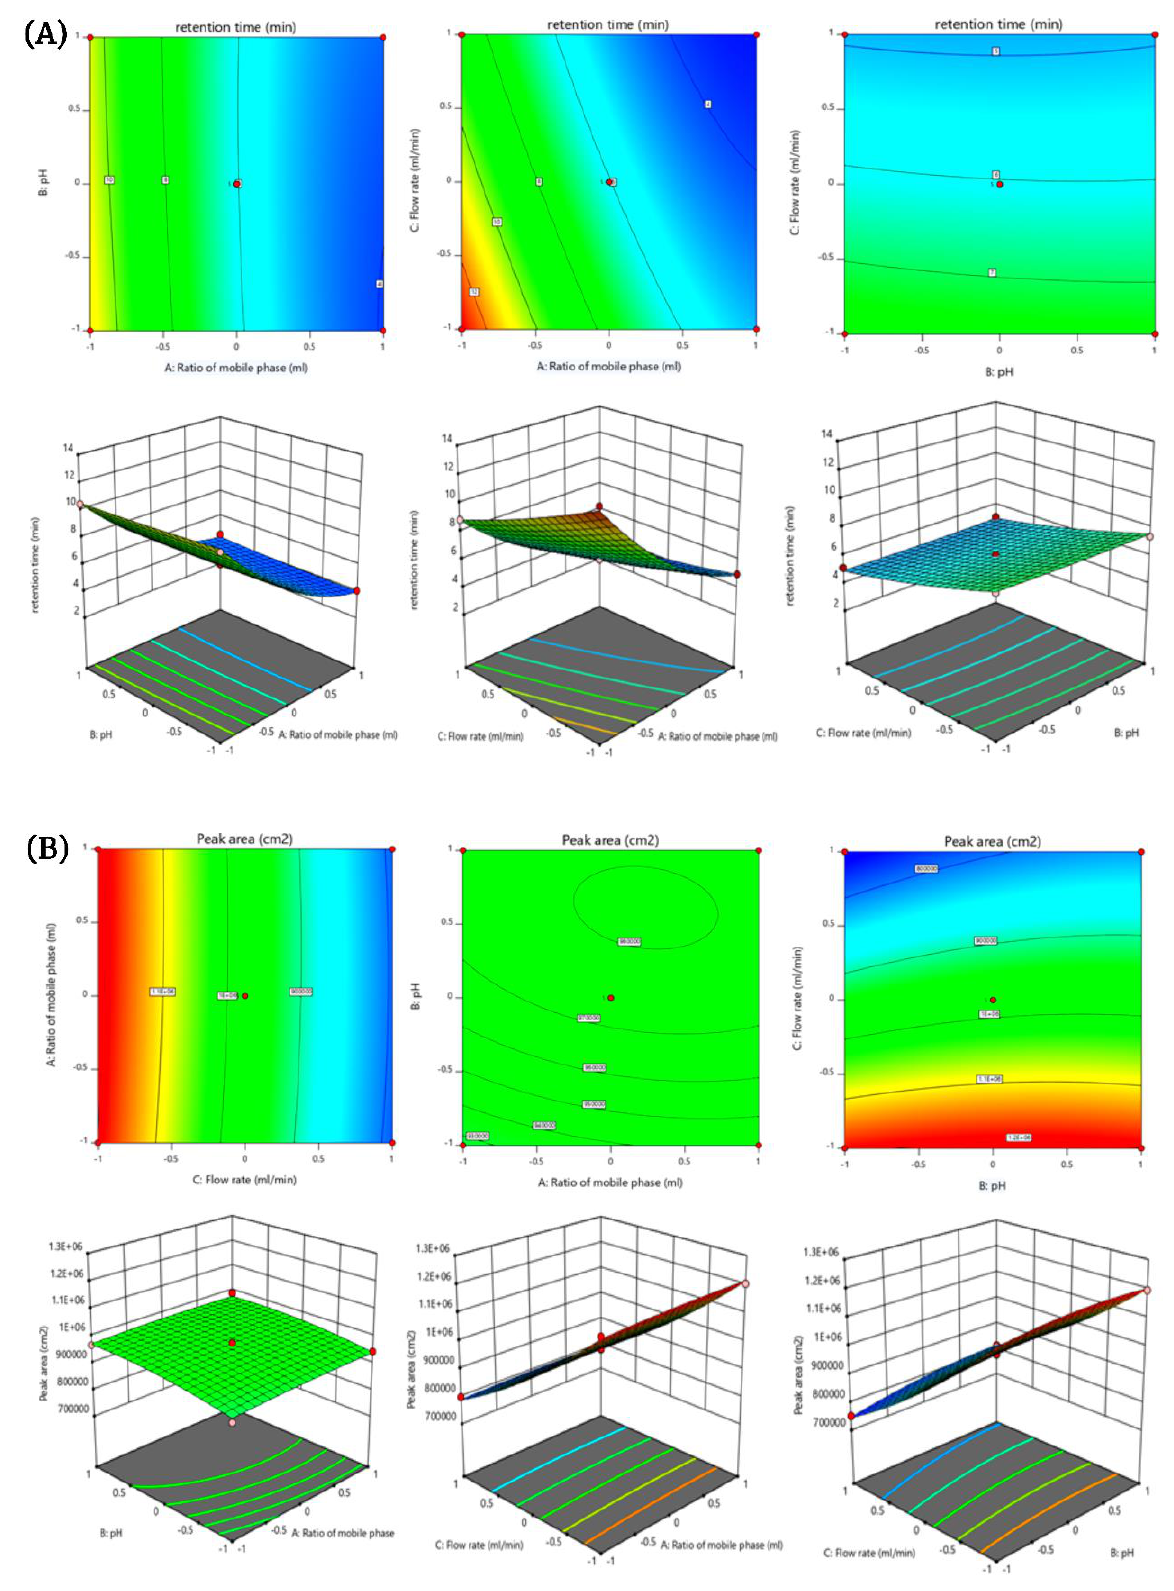
Figure 2. ( A ) 2D and 3D response surface plots representing the effect of factors Mobile phase ratio (A), pH of 0.1% OPA (B) and Flow rate (C) on retention time (R1) of XH. ( B ) 2D and 3D response surface plots representing the effect of factors Mobile phase ratio (A), pH of 0.1% OPA (B) and Flow rate (C) on Peak area (R2) of XH.